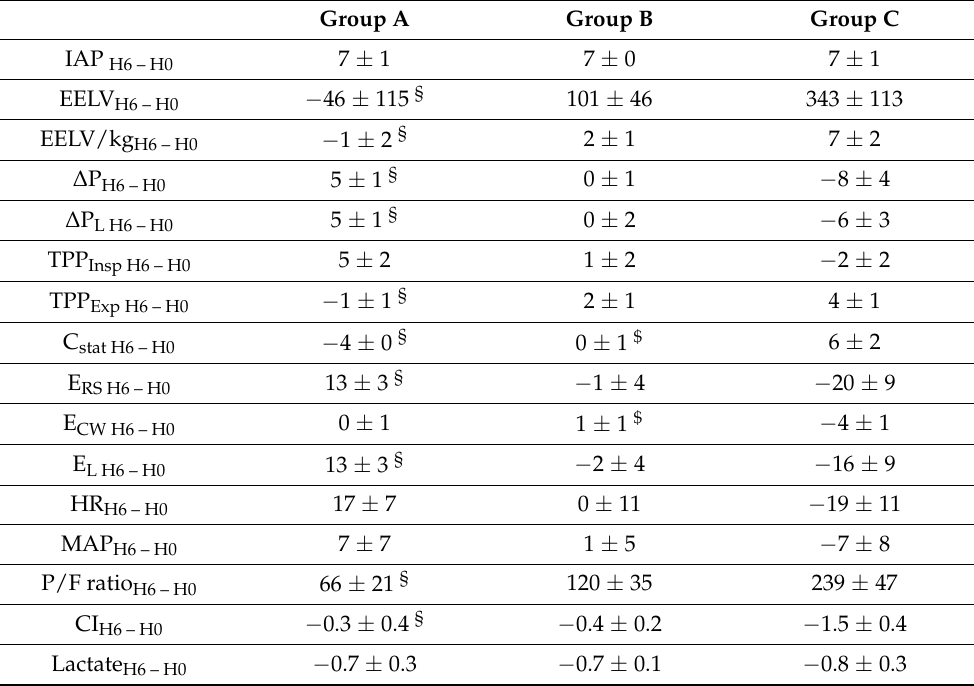
Table 3. Pulmonary and hemodynamic parameters generated by the subtraction of H0 from H6 showing the impact of different PEEP levels over 6 h. Group A Group B Group